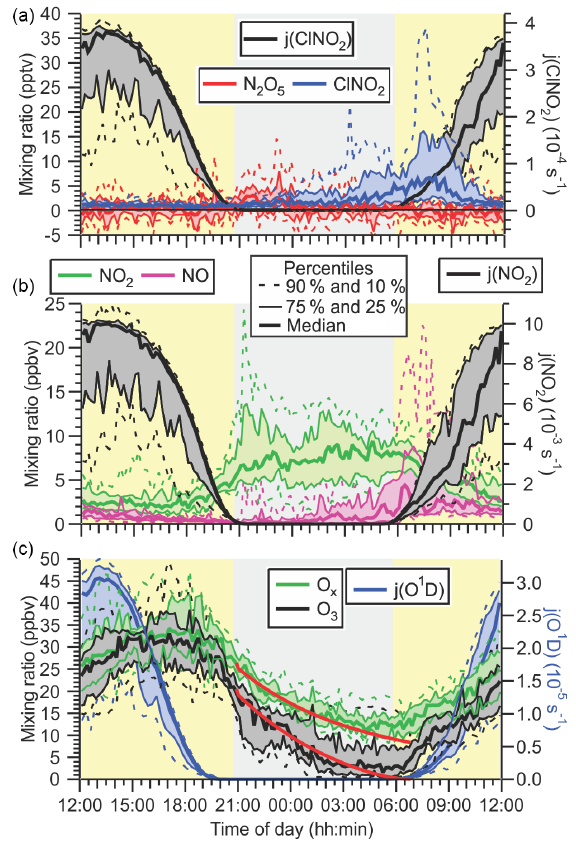
Figure 4. (a) Diurnal variation of ClNO 2 and N 2 O 5 mixing ratios (left axis) and ClNO 2 photolysis frequencies (right axis). (b) Di- urnal profiles of NO and NO 2 (left axis) and NO 2 photolysis fre- quency (right axis). (c) Diurnal profiles of O 3 and O x = O 3 + NO 2 (left axis) and O 3 → O( 1 D) photolysis frequency (right axis). The superimposed lines shown in red are results from a simple box model (see